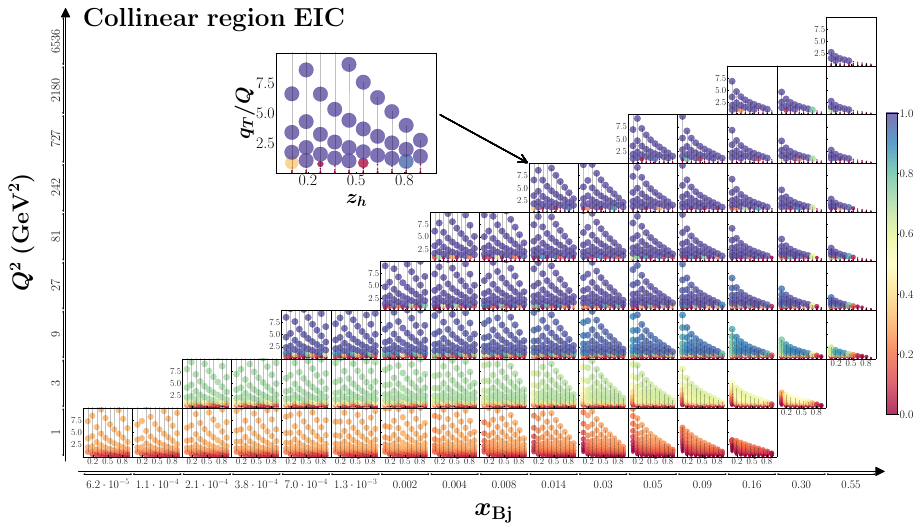
Figure 9 . Collinear affinity for EIC kinematics. Bin centers are located in the points corresponding to the bin average values of x and Q 2 (GeV 2 ). In each of these bins, various values of z Bj q T /Q can be measured. In each bin of fixed z h and q T /Q we plot the affinity as a dot with size proportional to the corresponding affinity value. Affinity is also color coded, according to the scheme on the right of the figure panel: red (and smaller) symbols correspond to low TMD affinity while dark blue (and larger) symbols to high collinear